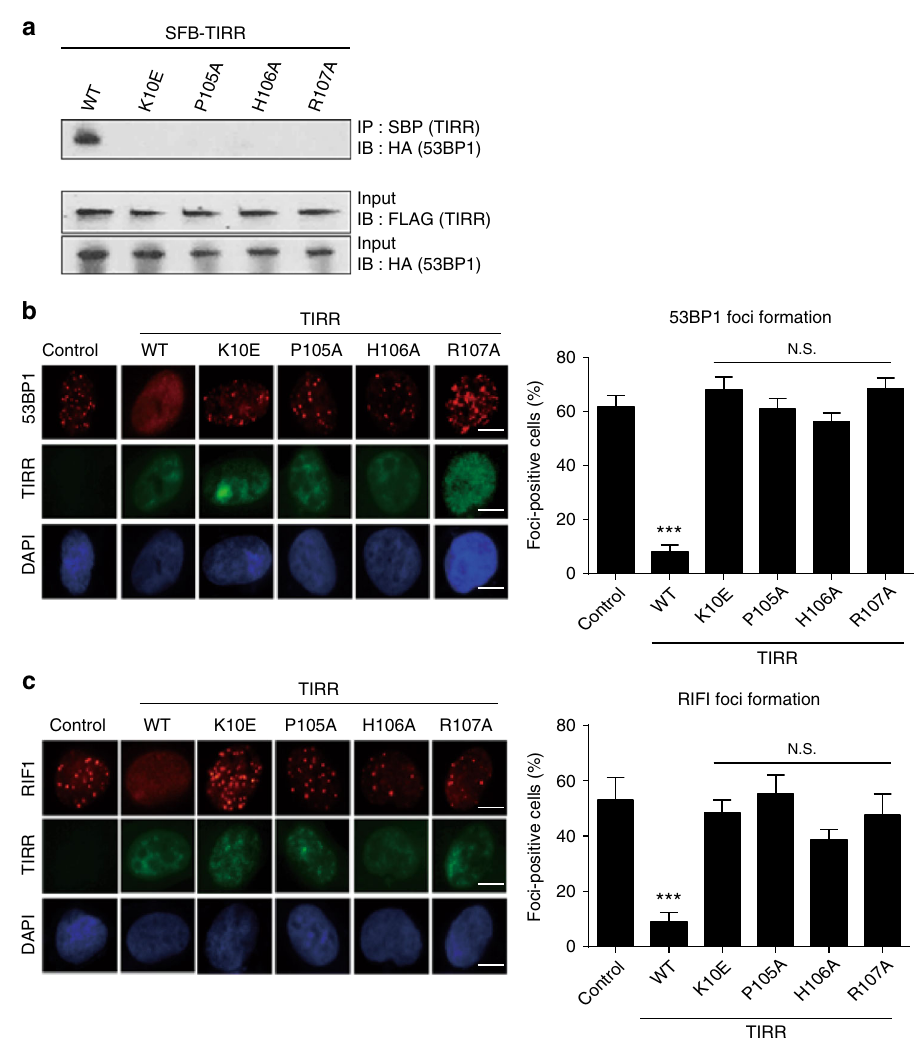
Fig. 4 TIRR regulates 53BP1-dependent DSB response. a The mutations of TIRR disrupt the TIRR – 53BP1 complex in vivo. TIRR, TIRR mutants, and 53BP1 were expressed in 293T cells. Co-IP and western blot were examined with indicated antibodies. b The mutations of TIRR do not affect the IRIF of 53BP1. Wild-type TIRR or its mutants were expressed in U2OS cells. The cells were treated with 10 Gy of IR. The IRIF of endogenous 53BP1 was examined by immuno fl uorescence staining. Foci positive cells were examined from three independent experiments with 100 randomly selected cells in each experiment. Scale bar represents 5 µ m. c The mutations of TIRR do not affect the IRIF of RIF1. Data are represented as mean ± s.d. as indicated from three independent experiments. N.S.: non signi fi cant; ***: statistically signi fi cant ( p < 0.001). Scale bar represents 5 µ